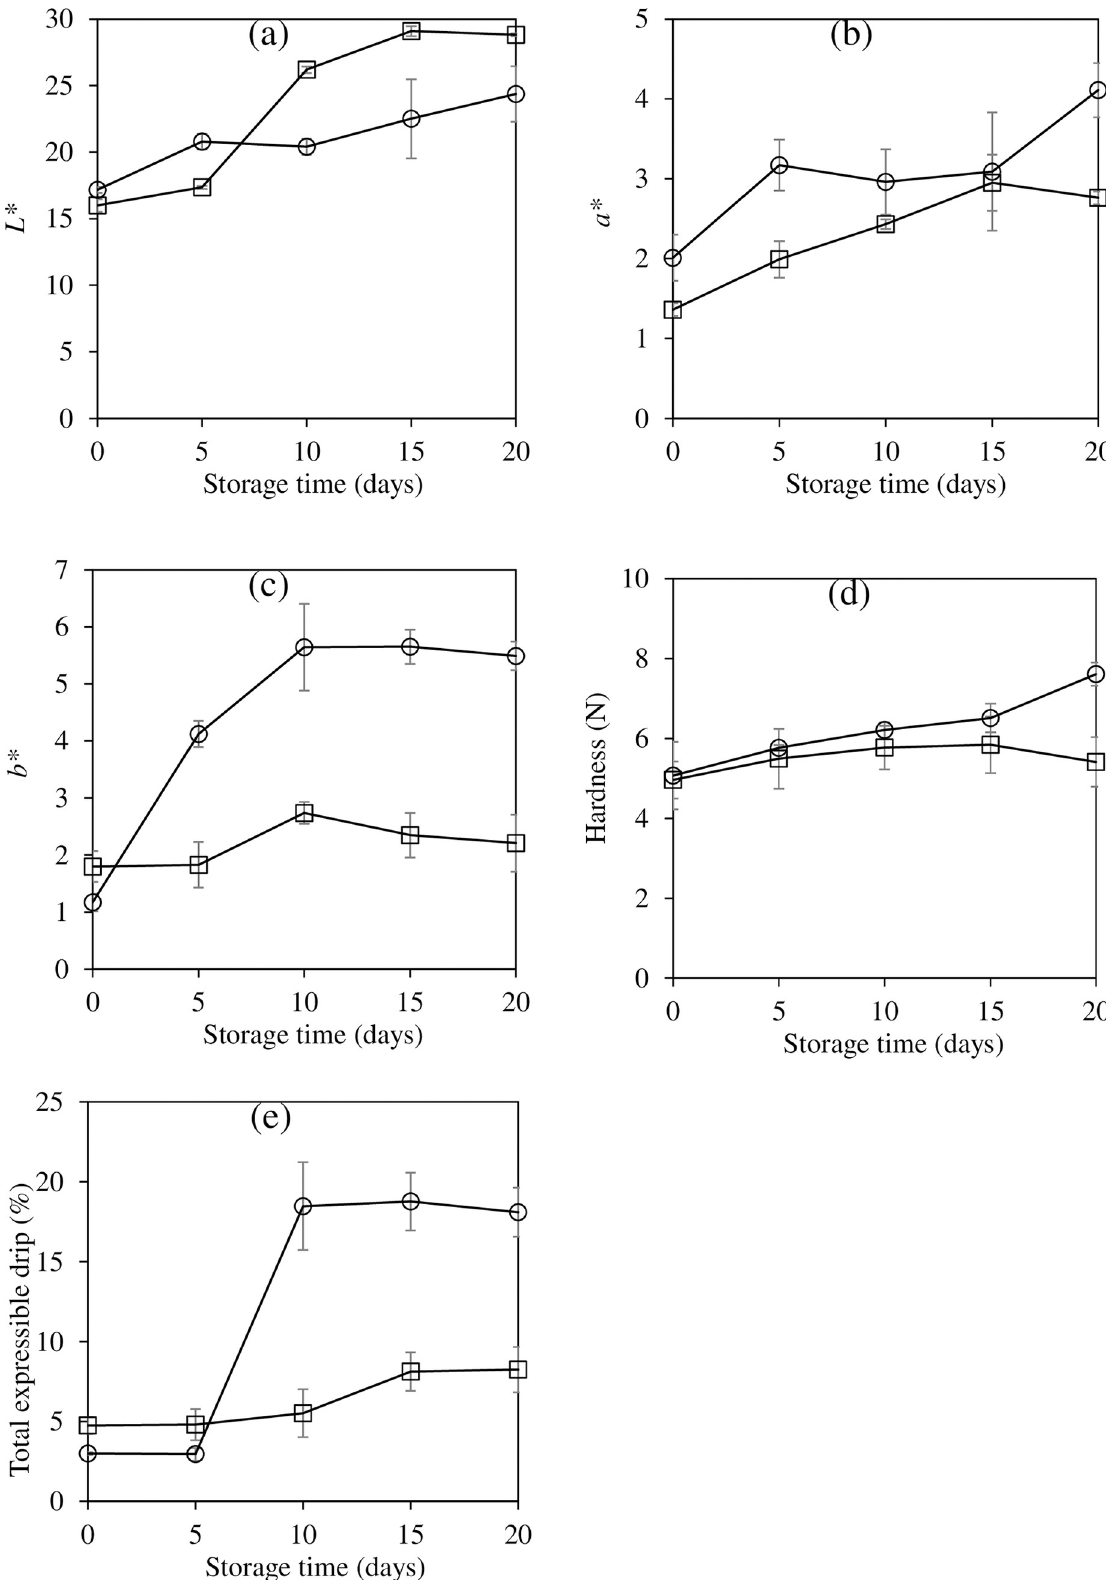
Fig 2. Changes in L � value (a), a � value (b), b � value (c), hardness (d), and total expressible drip (e) of semi-dried Chinese style tilapia sausages formulated with pork back fat (control; � ) and carrageenan based emulgel ( □ ) during storage at room temperature. https://doi.org/10.1371/journal.pone.0250512.g002 PLOS ONE | https://doi.org/10.1371/journal.pone.0250512 April 22,